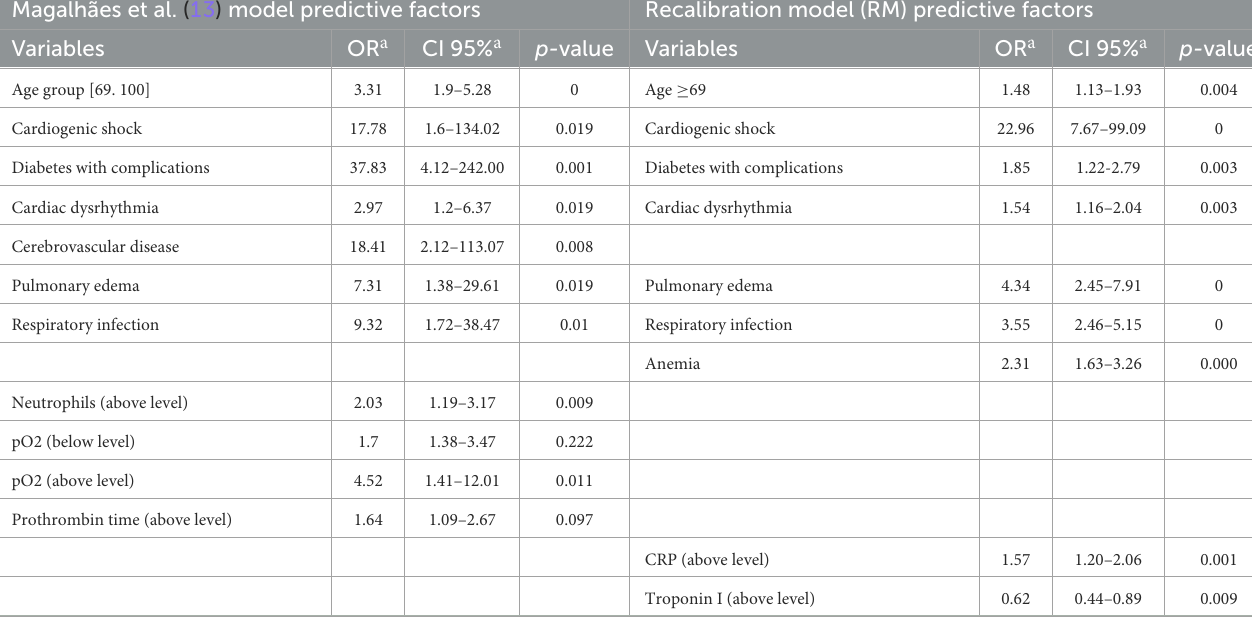
TABLE 6 Comparison of the values obtained for OR and 95% CI between the models. Magalhães et al. (13) model predictive factors